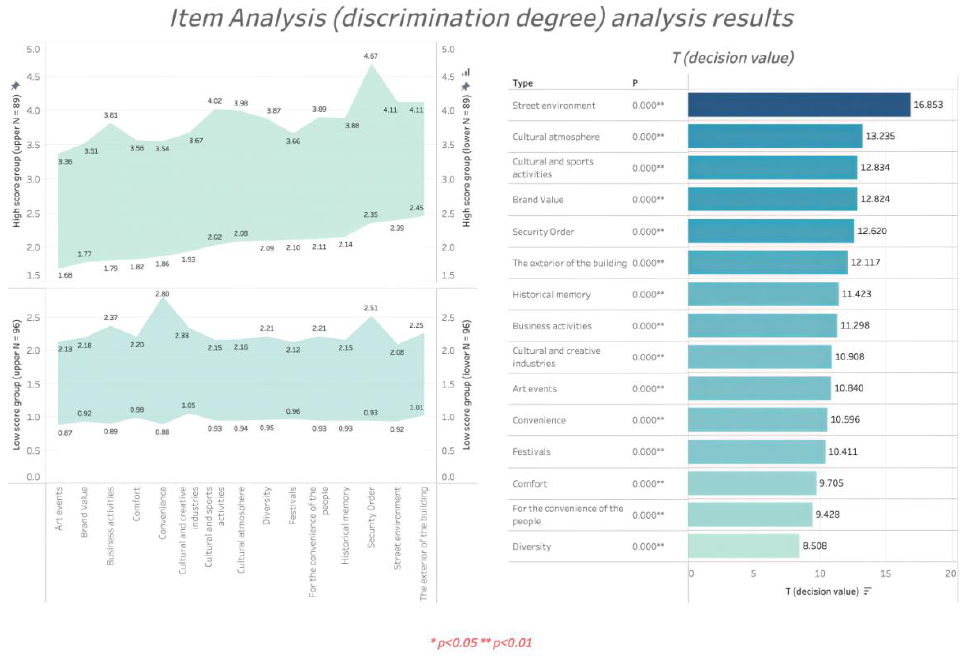
Figure 5. T -test difference analysis plot. (An asterisk corresponds to a significant at the 5% significance level, * p < 0.05 means that something is at least 95% certain that it will happen. Two asterisks correspond to a significant 1% level, and ** p < 0.01 means that something is at least 99% certain that it will happen).